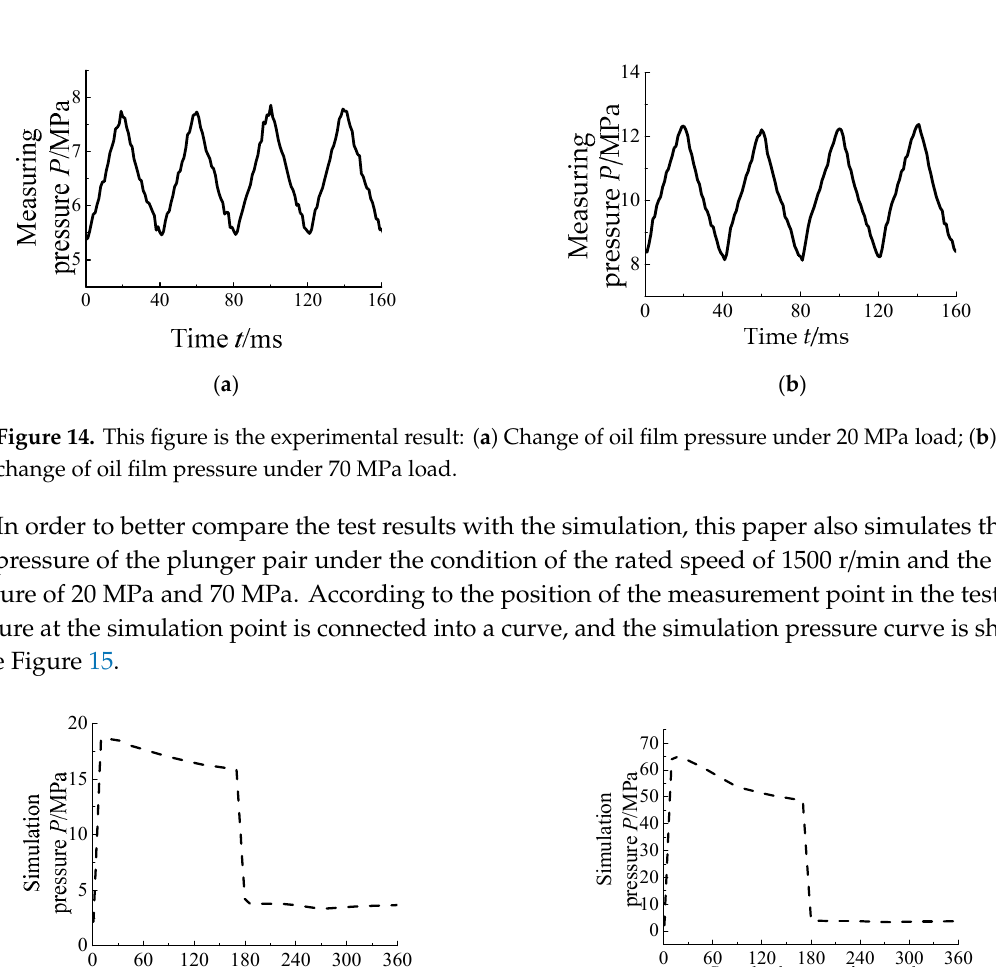
14 of 17 Figure 12. The figure is the schematic diagram of the test bed. 1 — motor; 2 — coupling; 3 — pump; 4 — pressure gauge; 5 — high pressure relief valve; 6 — relief valve (relief valve); 7 — air cooler; 8 — oil return filter; 9 — air filter; 10 — level gauge; 11 — filter; 12 — fuel tank. The assembled test device is shown in Figure 13. Pressure gauge Motor Pump Overflow valve ( a ) ( b ) Figure 13. The figure above shows the experimental object: ( a ) Physical drawing of pump; ( b ) physical drawing of pump test bed.